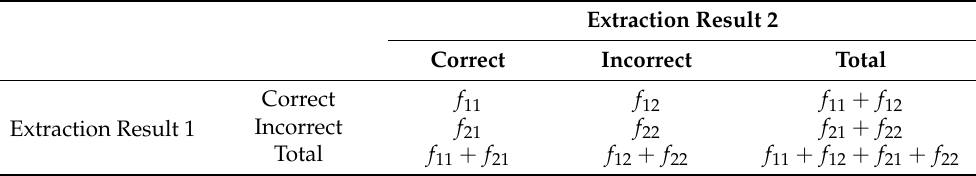
Table 6. Data layout for McNemar test between two extraction results.